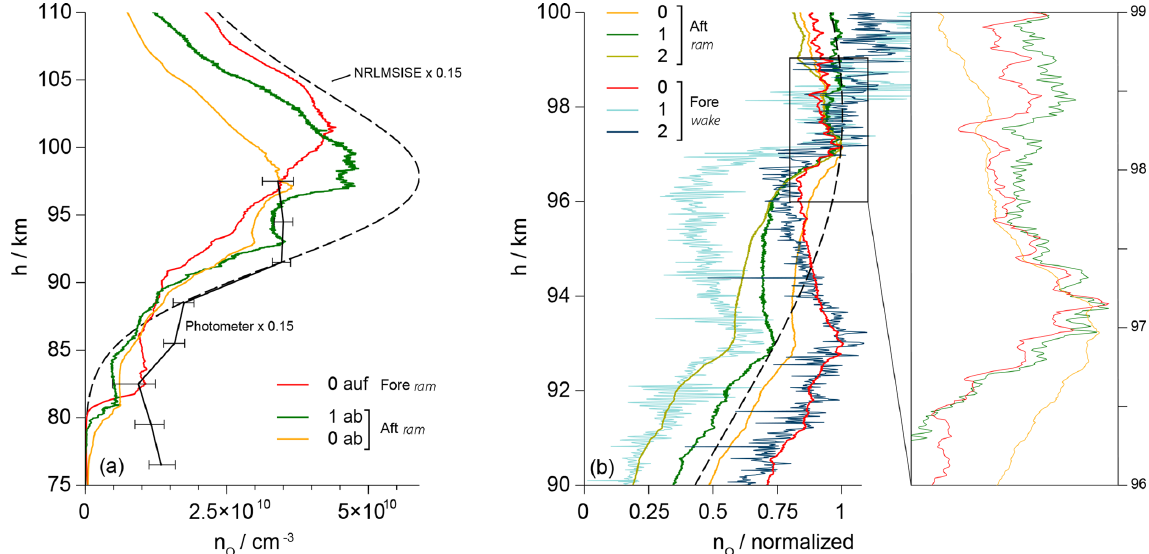
Figure 13. (a) Comparison of the ram profiles of different sensors measured by Fore-0 during the upleg as well as by Aft-0 and Aft-1 during the downleg. Profile derived from the photometer data and values of the NRLMSISE-00 atmospheric model are scaled by a factor of 0.15. (b) Normalized profiles of all sensors during the downleg, with fore sensors in wake and aft sensors in ram position. The inset shows a detail of the profiles featuring small-scale